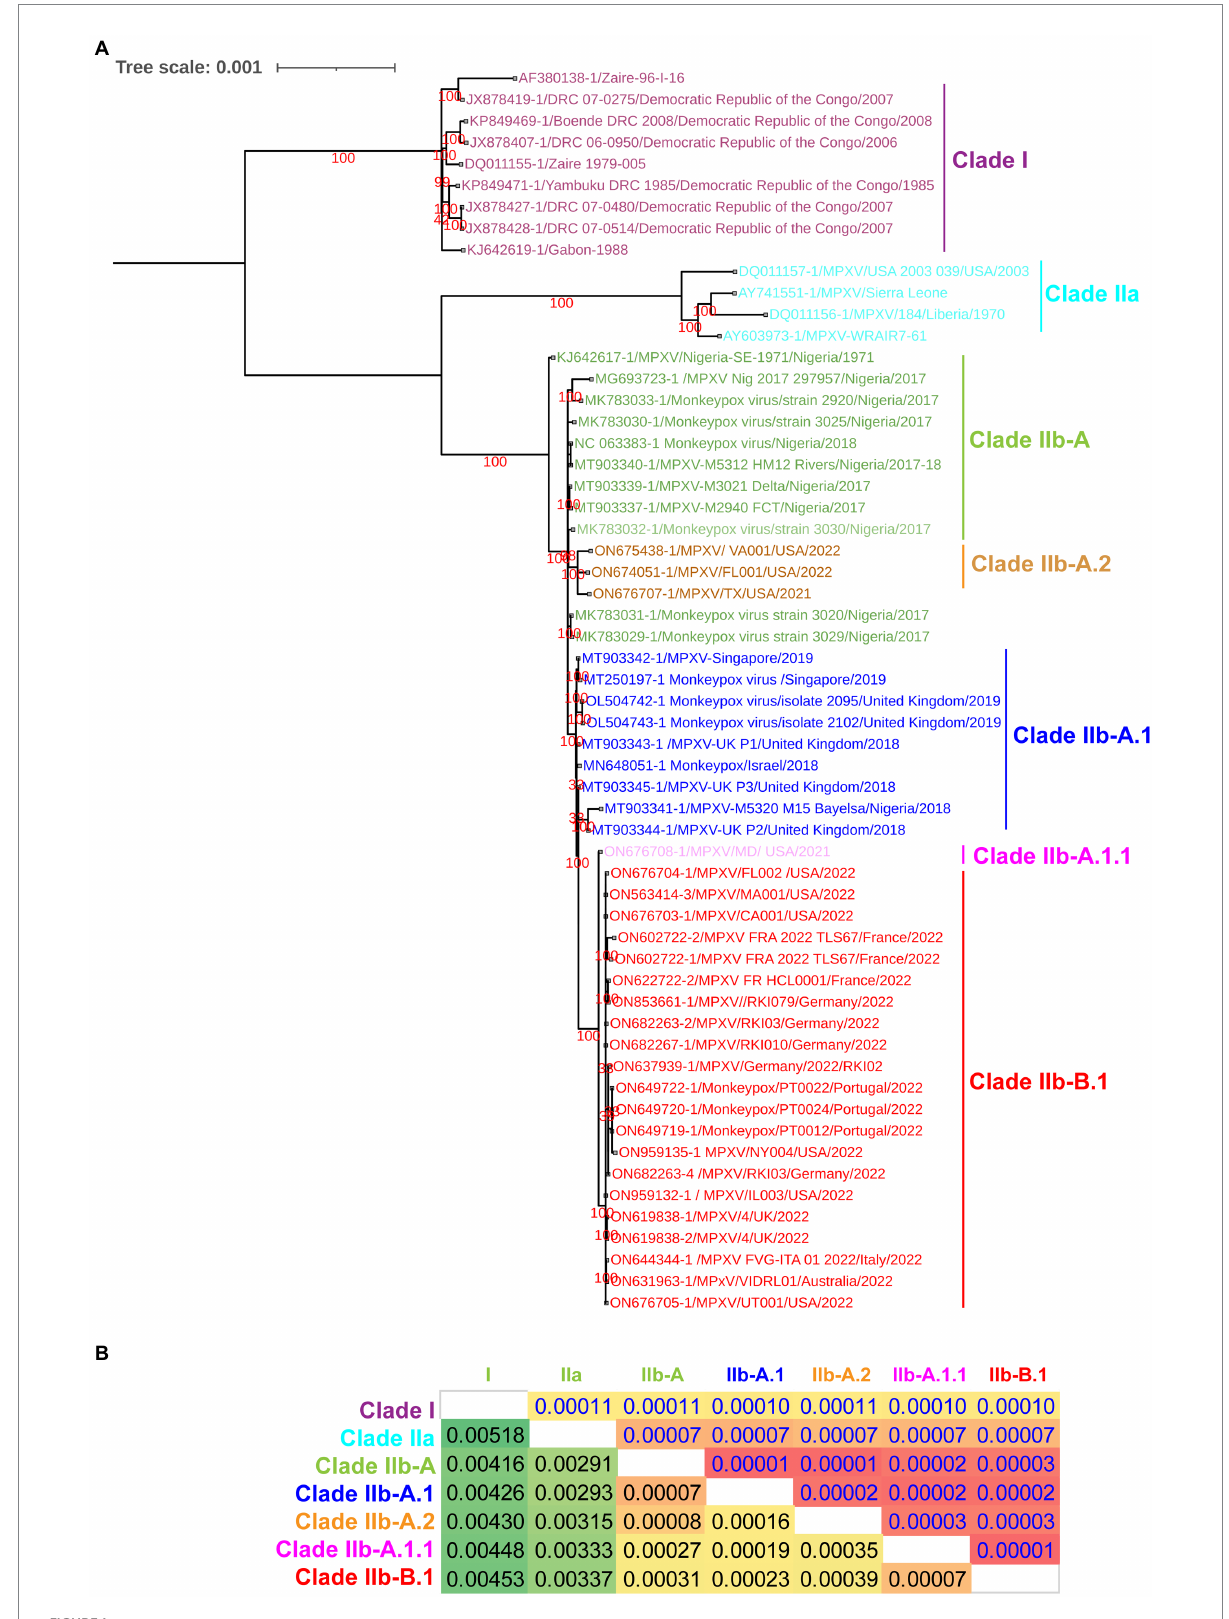
FIGURE 1 Complete genome-level genetic diversity in the different clades and lineages of the monkeypox viruses. (A) The MPXV different clades and lineages at whole genome levels are also classified as similar according to a recent report that classified MPXV at core SNPs (Isidro et al., 2022)